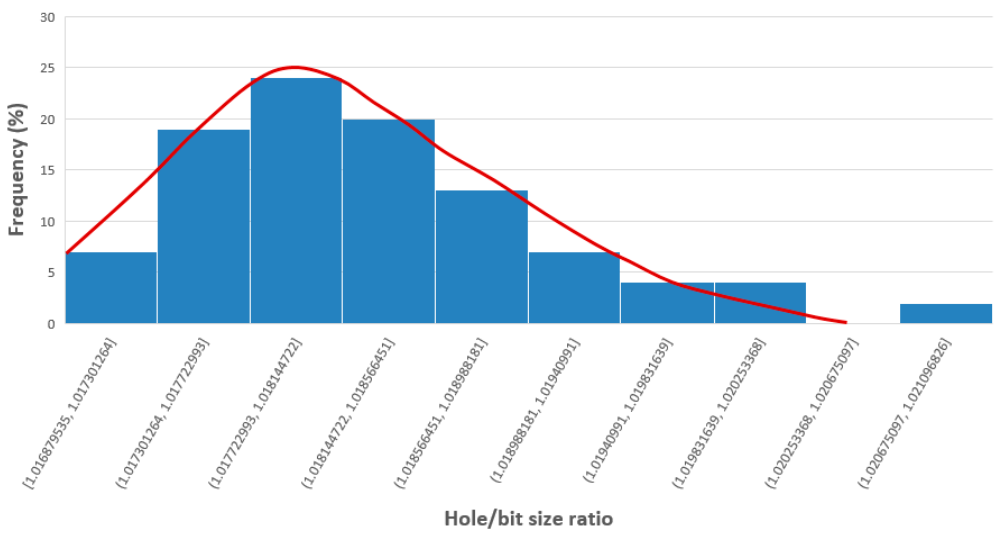
Figure 4. Histogram of hole/bit ratio.